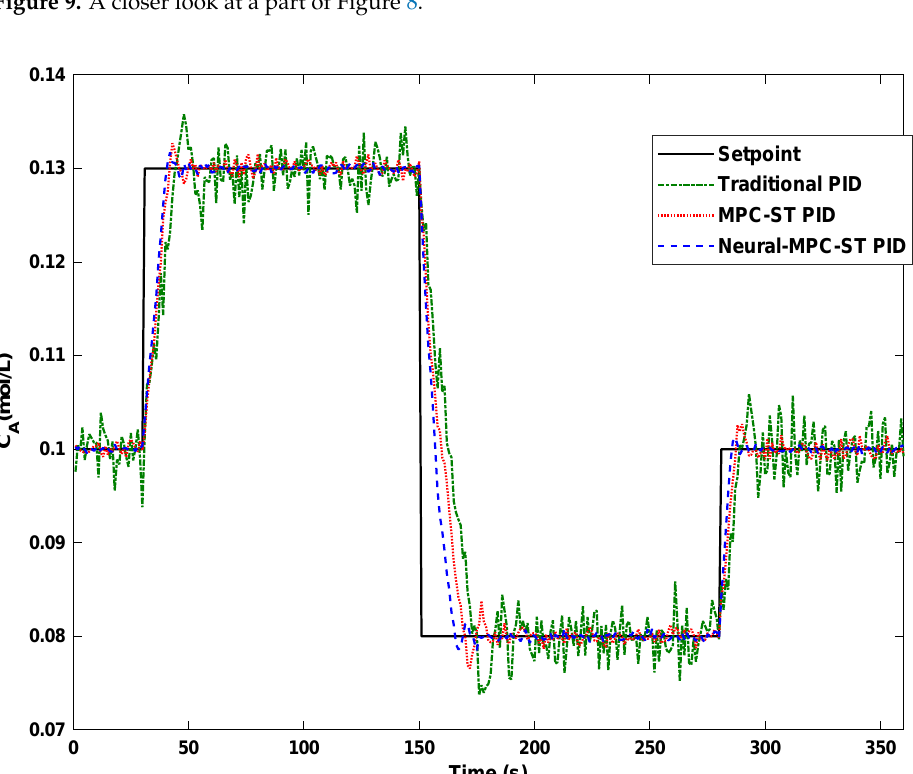
Figure 10. Comparison of the performance of the three control methods, taking into account the ± 20% change in tank